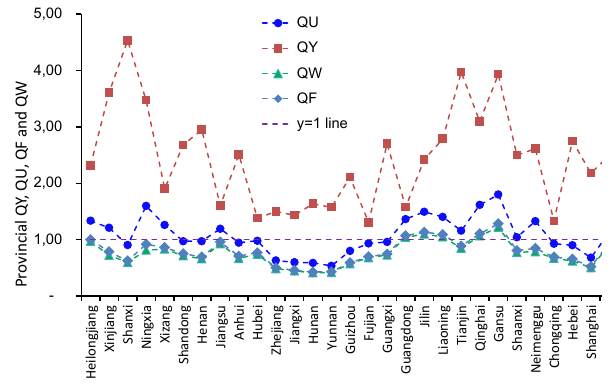
Fig.8 . Contributions of three categories to the wheat production indicators. 624 Figure 8. Contributions of three categories to the wheat production